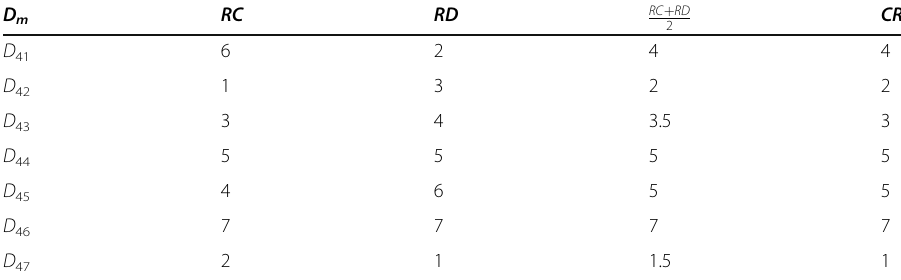
Table 16 A composite rank measure produced by averaging RC and RD D m